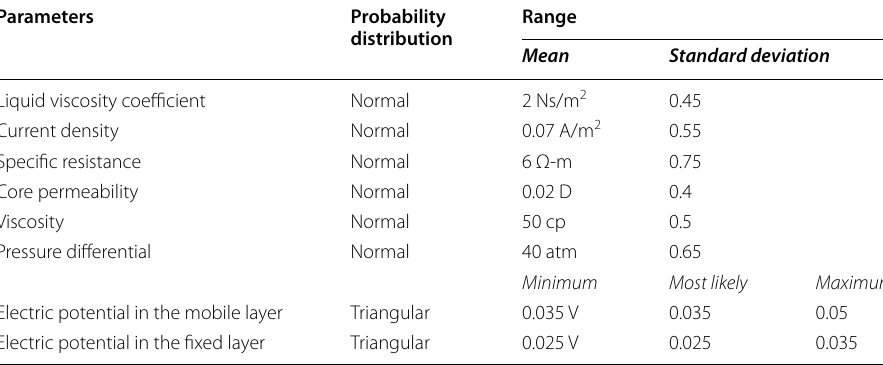
10,000 iterations of incremental recovery from EK‑EOR were ran and the probability of obtaining values greater than 5%, 10%, 35%, and 50% were obtained using ` Carlo simulation